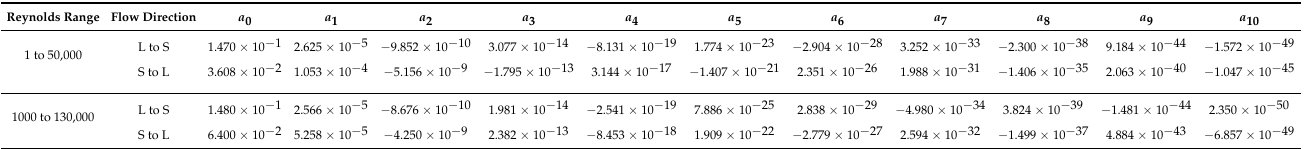
Table 2. Constant values of the discharge coefficient equation for two different range of Reynolds number and different flow directions, large to small reservoirs, and vice